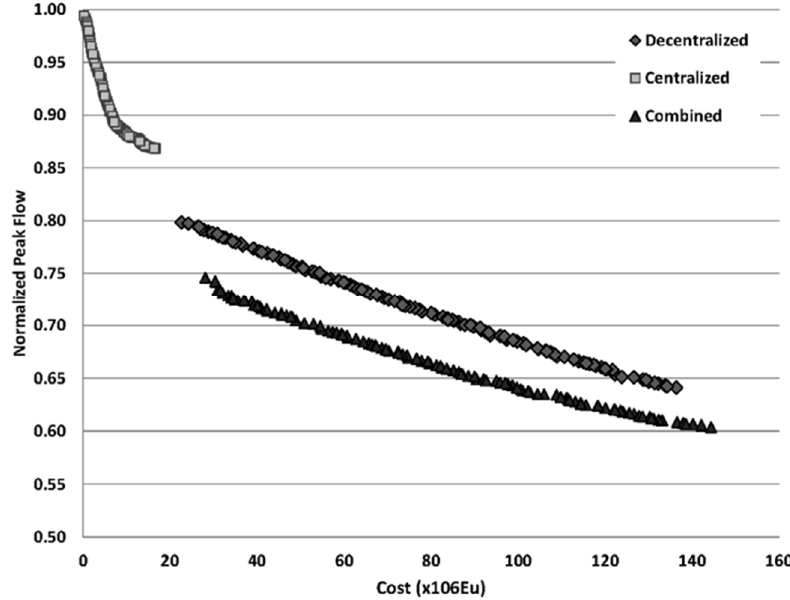
Figure 7. Pareto fronts obtained for each scenario.